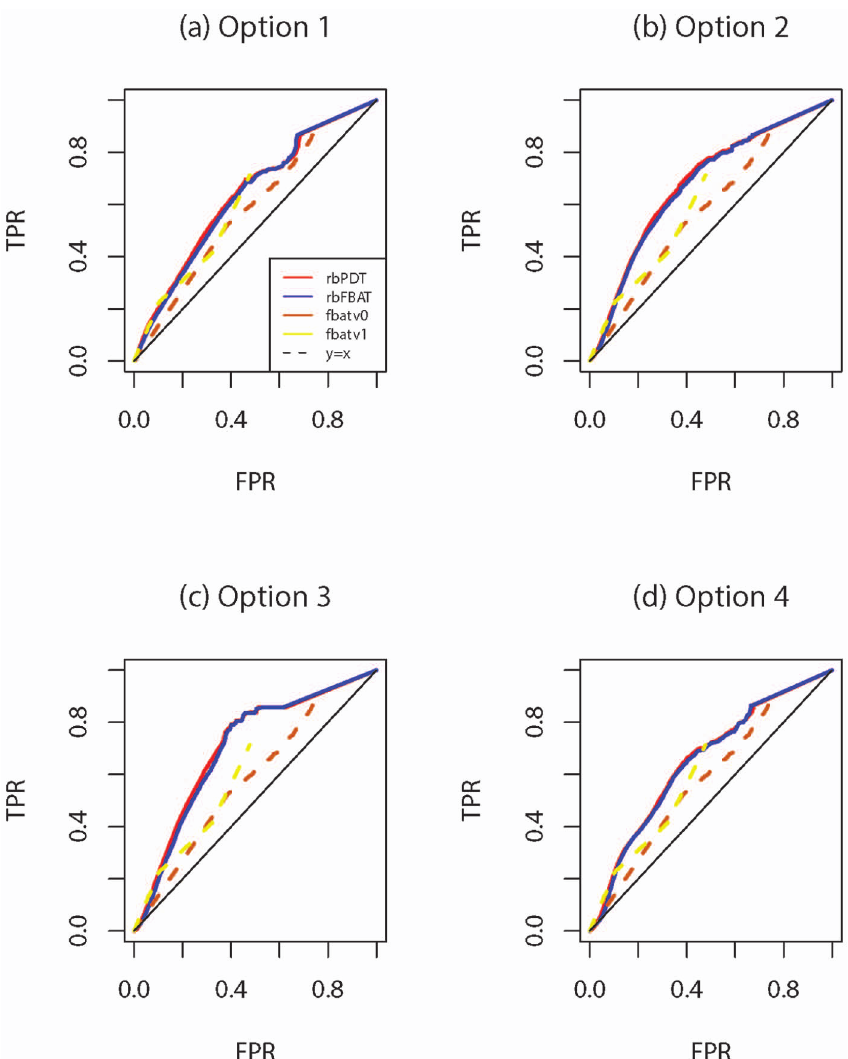
Figure 4. 200 replicate results: ROC curves for fbatv0 , fbatv1 , (a) rbPDT and rbFBAT with Option 1; (b) rbPDT and rbFBAT with Option 2; (c) rbPDT and rbFBAT with Option 3; (d) rbPDT and rbFBAT with Option 4.